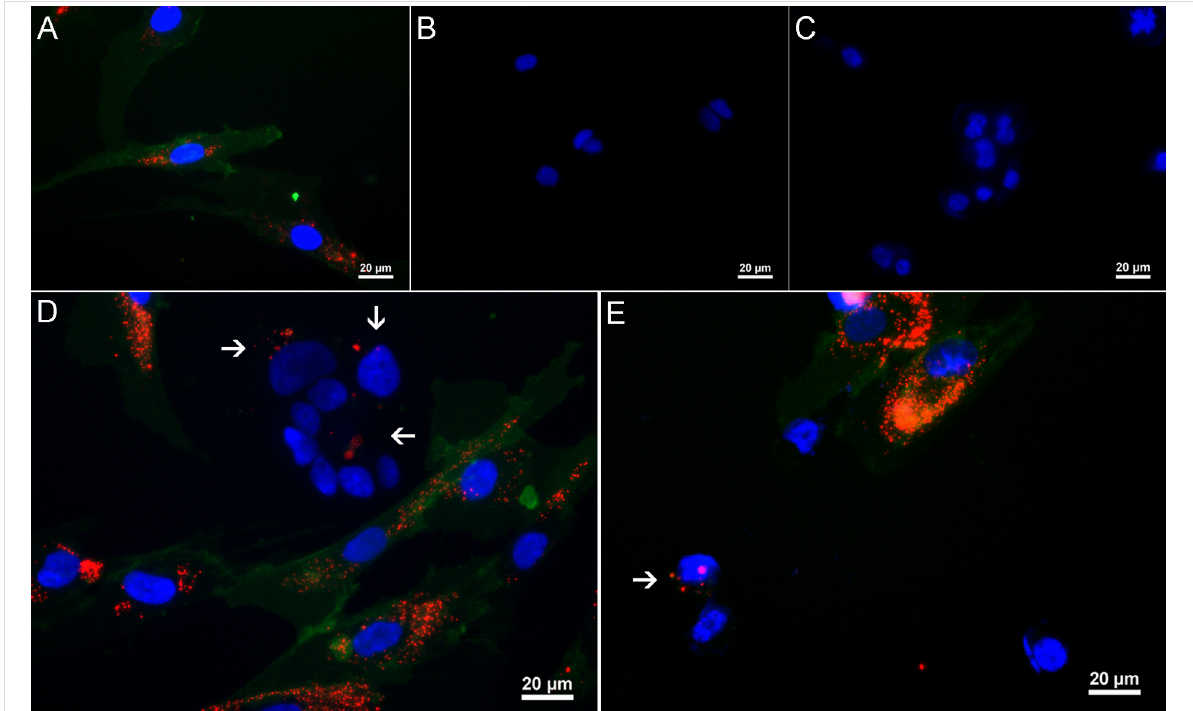
Figure 7: Fluorescence imaging of quantum dot (QD) intracellular accumulation in MCF7 and MDA-MB-231 cells during 3D co-culture. Nanoengi- neered MSCs (A), MCF7 (B) and MDA-MB-231 (C) cells were stained with CD90 FITC to distinguish cell populations. Single QD-positive/CD90-nega- tive cells observed in MSC/MCF7 (D) and MSC/MDA-MB-231 (E) co-cultures. White arrows indicate cancer cells with internalised QDs. Blue – Hoechst, green – CD90 FITC, red – QDs. Scale bar – 20 μ